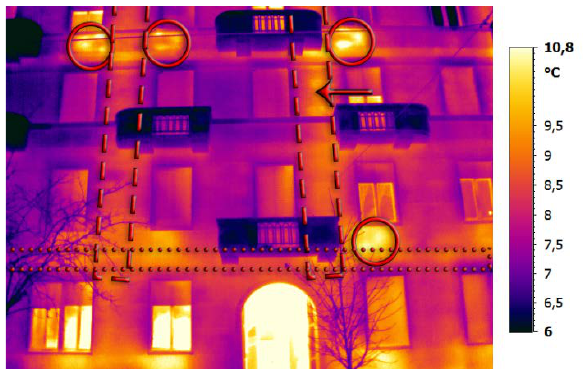
Figure 7 - Detail of the temperature distribution on the area around and above the main entrance (Case Study 2). The thermogram shows the heat loss due to the different thickness of the masonry, its finishing, and the location of heater/pipes.